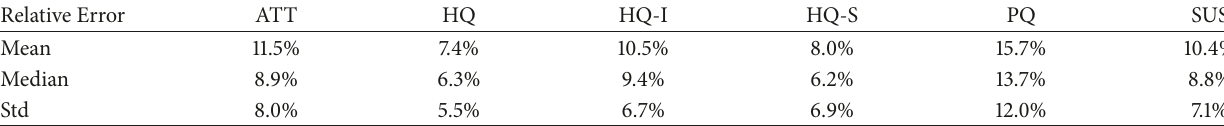
Figure 14: Relative feature importance measures from 1 % (205) of best GBRF estimators from grid search as described in Section 3.3.2. The orange rectangle highlights features added via PCA transformation. Relative feature importance is depicted on a log scale on the bottom. Table 3: Relative absolute prediction errors for AttrakDiff-2 and SUS test set samples. Predictions are computed by six separately trained Stochastic Gradient Boosting Regression Forests (GBRFs), one for each figure of merit. Note that each training process only utilizes the interaction log data. Results displayed are the median values of 10 4 randomly initialized training